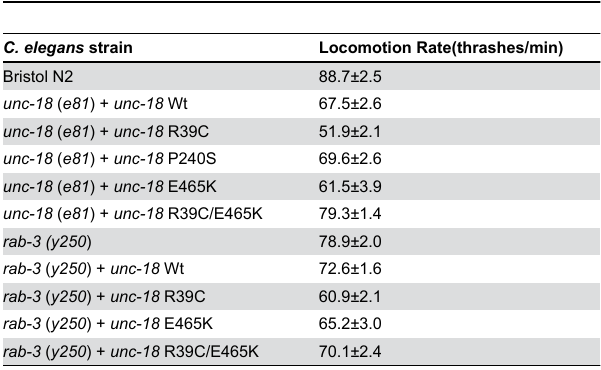
Table 1. Basal locomotion rates of C. elegans strains used in this